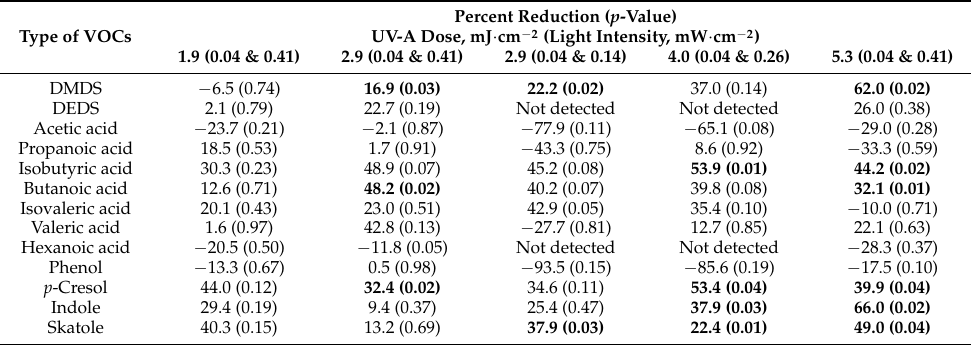
Table 2. Mitigation of odorous VOCs with UV-A photocatalysis treatment. Control temperature = 28.5 ± 2.3 ◦ C, control RH = 69.8 ± 9.5%, treatment temperature: 31.5 ± 1.2 ◦ C, treatment RH = 66.0 ± 4.3%. Bold signifies statistical significance.